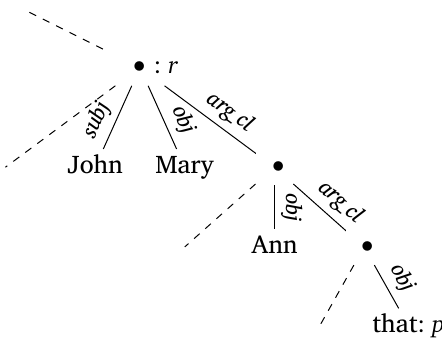
Figure 19: Instantiation of the logical constraint for p 6